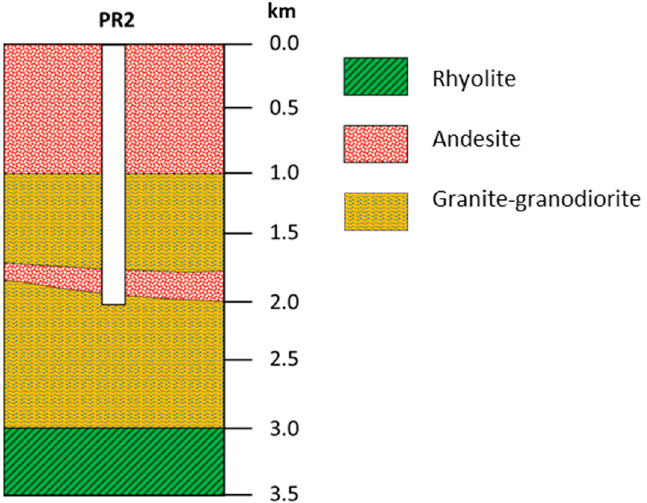
Figure 6. Simplified lithology based on core drilled wells from Cerritos Colorados geothermal field.